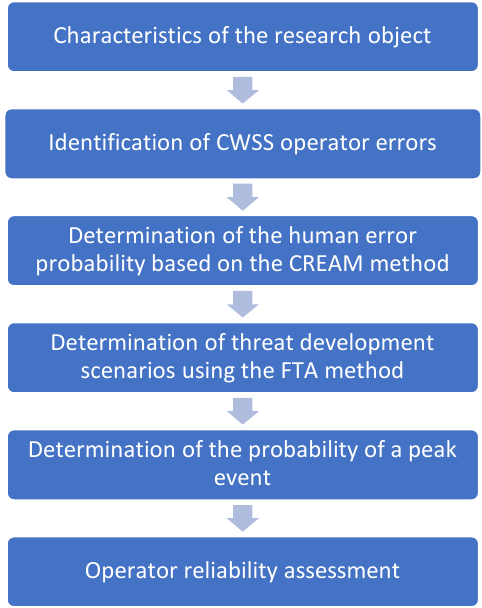
Figure 2. Scheme of the performed analysis.